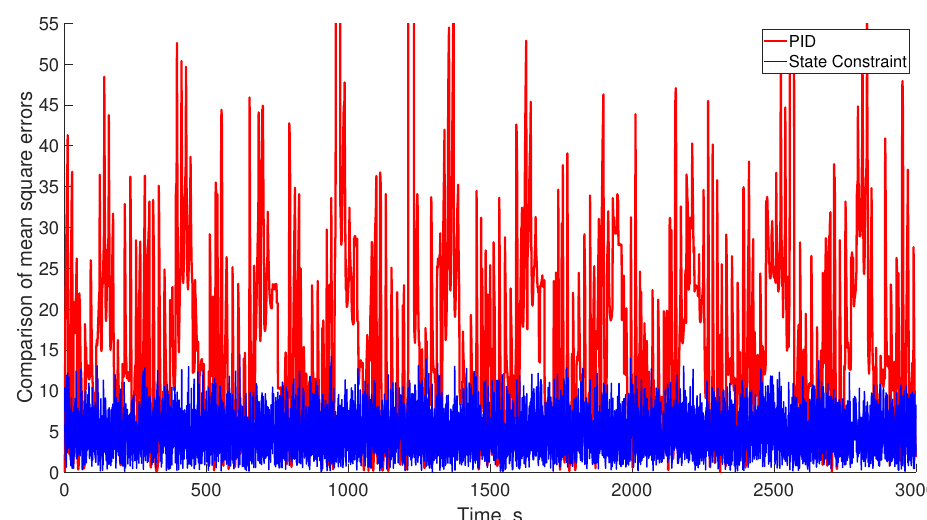
Figure 7. Comparison of the mean square error between the proposed state constraint and the tradi- tional state feedback control form.